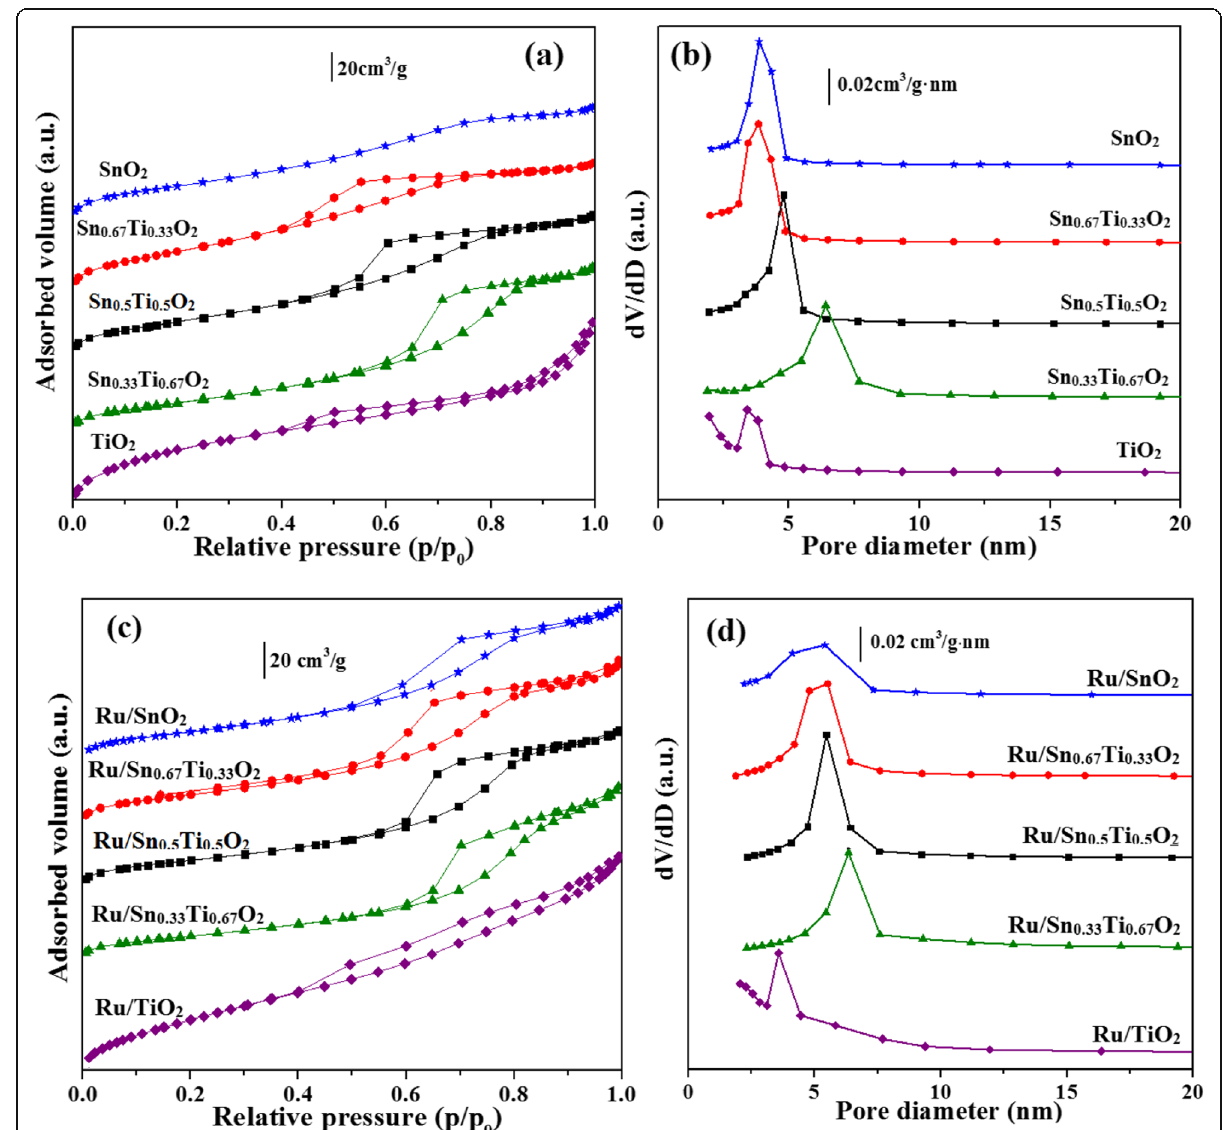
Fig. 5 N 2 adsorption-desorption isotherms of Sn x Ti 1 − x O 2 ( a ) and Ru/Sn x Ti 1 − x O 2 ( c ) the pore size distribution of Sn x Ti 1 − x O 2 ( b ) and Ru/Sn x Ti 1 − x O 2 ( d